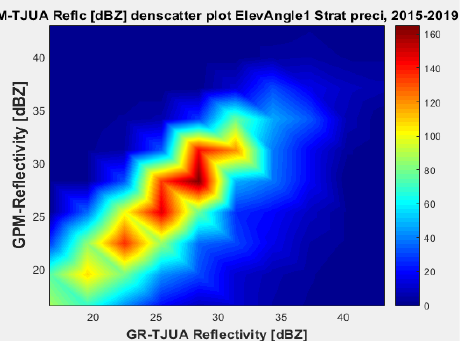
Figure 7. GPM ‐ Ka vs. NEXRAD TJUA for stratiform precipitation (angle 1).